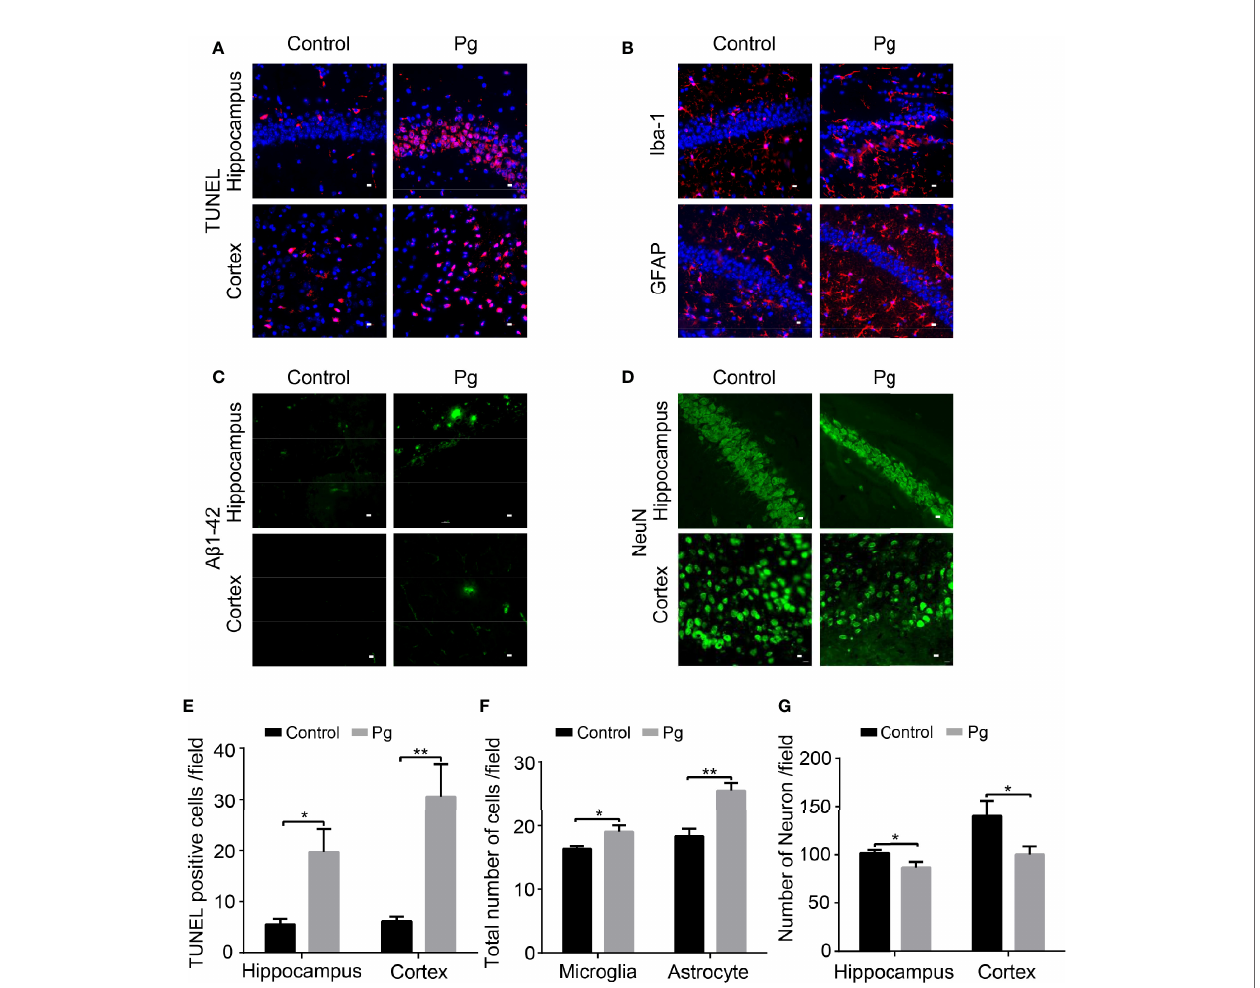
FIGURE 5 | Immunohistochemical staining of the hippocampus and cortex. (A) Representative image presenting TUNEL-positive cells in the hippocampus and cortex. (B) Representative image presenting Iba-1 and GFAP-immunopositive cells in the hippocampus. (C) Representative section showing amyloid plaque in the hippocampus and cortex. (D) Representative image presenting NeuN-positive cells in the hippocampus and cortex. (E) Comparison of the difference in the number of TUNEL-positive cells. (F) Comparison of the difference in the number of GFAP and Iba-1-positive cells in the hippocampus. (G) Comparison of the difference in the number of NeuN-positive cells in the hippocampus and cortex. n = 6, data were shown as means ± SEM. * p ≤ 0.05; ** p ≤ 0.01. Scale bar, 10 m